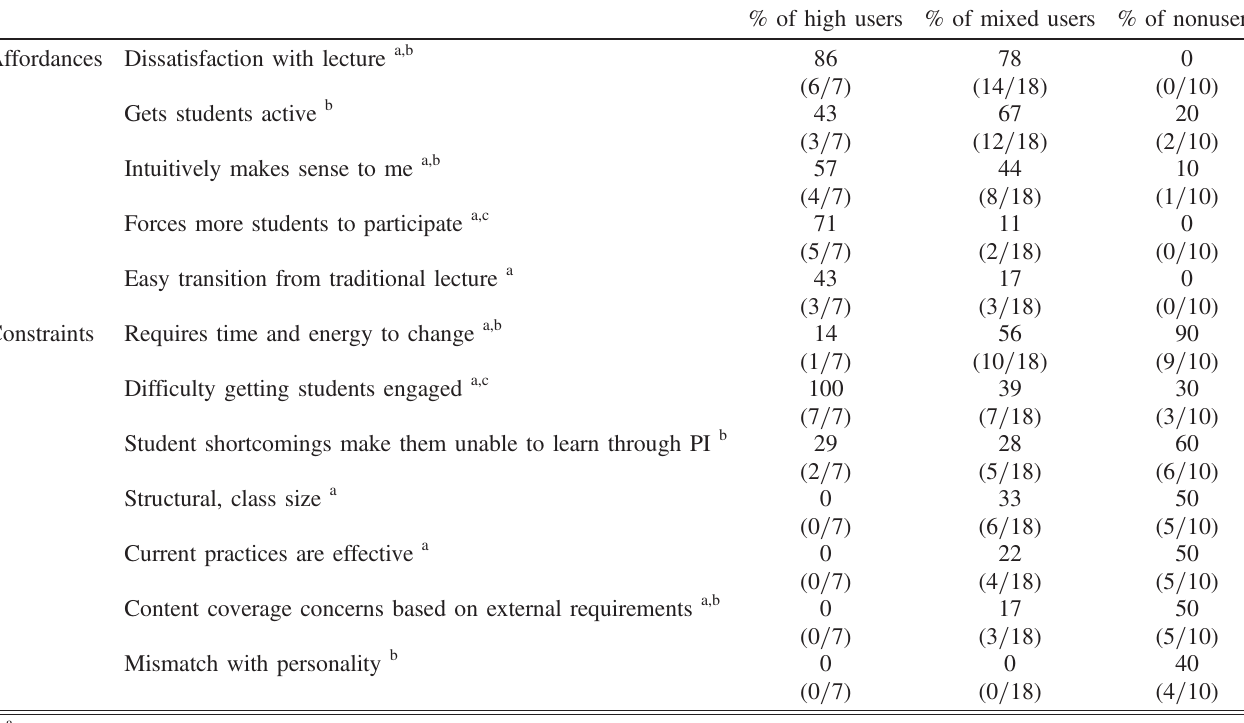
TABLE VIII. Prevalence of perceived affordances and constraints by user group (for those with meaningful differences). High